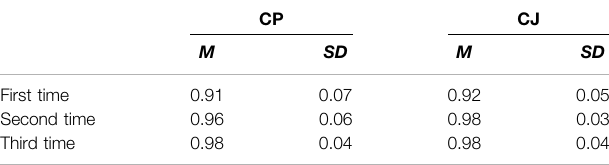
TABLE 1 | Mean proportions and standard deviations ( SD ) in recognition tasks. TABLE 2 | Results of the generalized linear mixed effects model for the